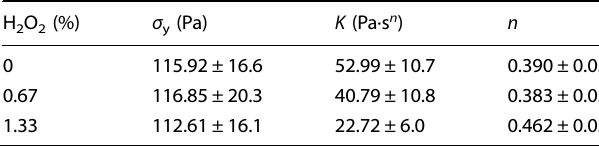
Table 1. Herschel – Bulkley parameters of three AAm/nanoclay suspensions used in